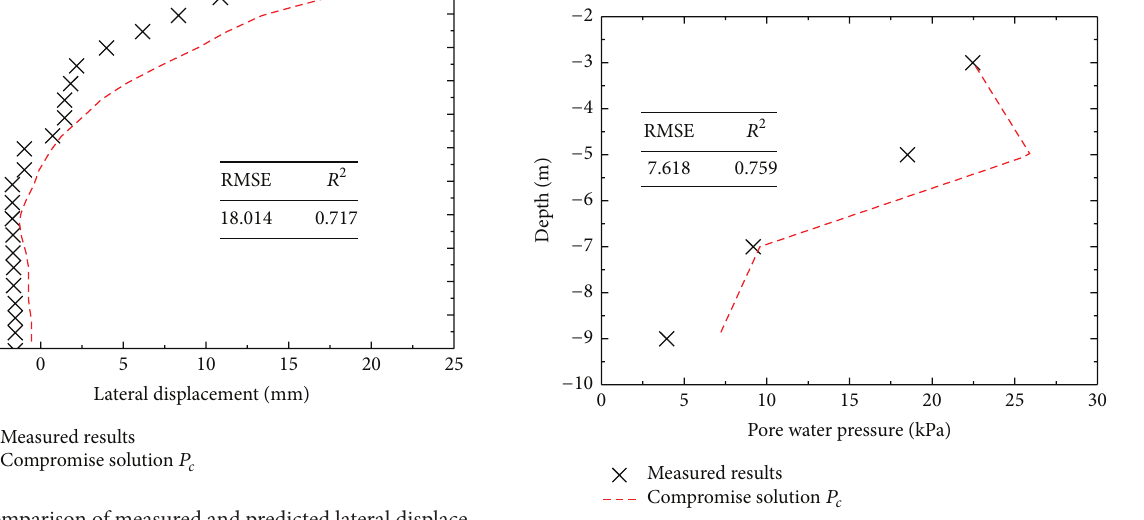
Figure 17: Comparison of measured and predicted pore water pressure at impact location B using compromise solution from back analysis of 1st blow at impact location